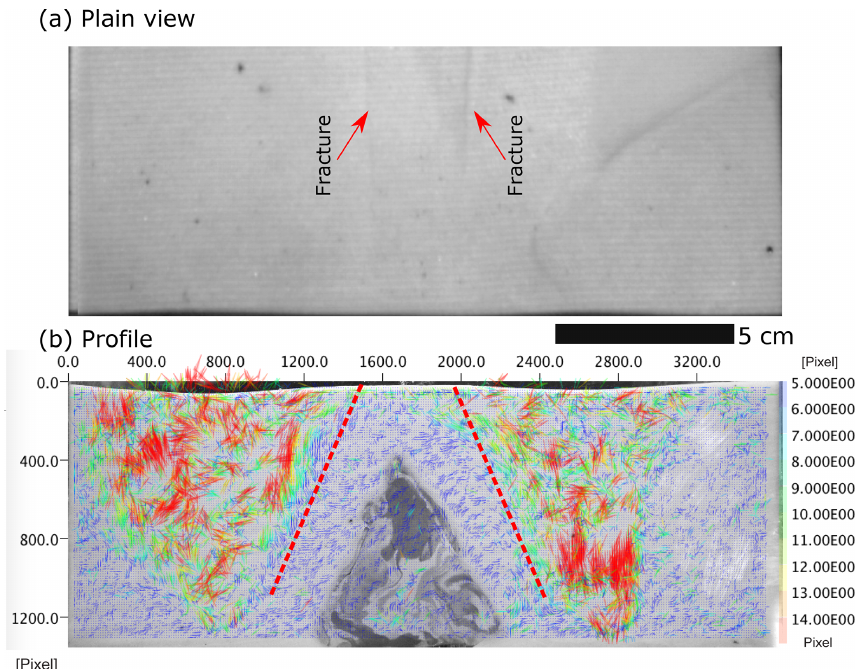
Figure 2. Experimental results: (a) top-view photograph of the experiment showing the formation of fractures at the surface of the model and (b) photograph of the lateral wall of the experiment with the displacements obtained with